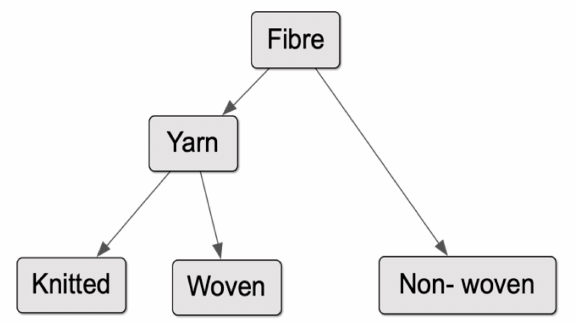
Figure 11. Structural map of basic textiles based on scale—fibres are the basic building block that can be applied to all fabric structures; i.e., knitted and woven textiles via yarns and directly into